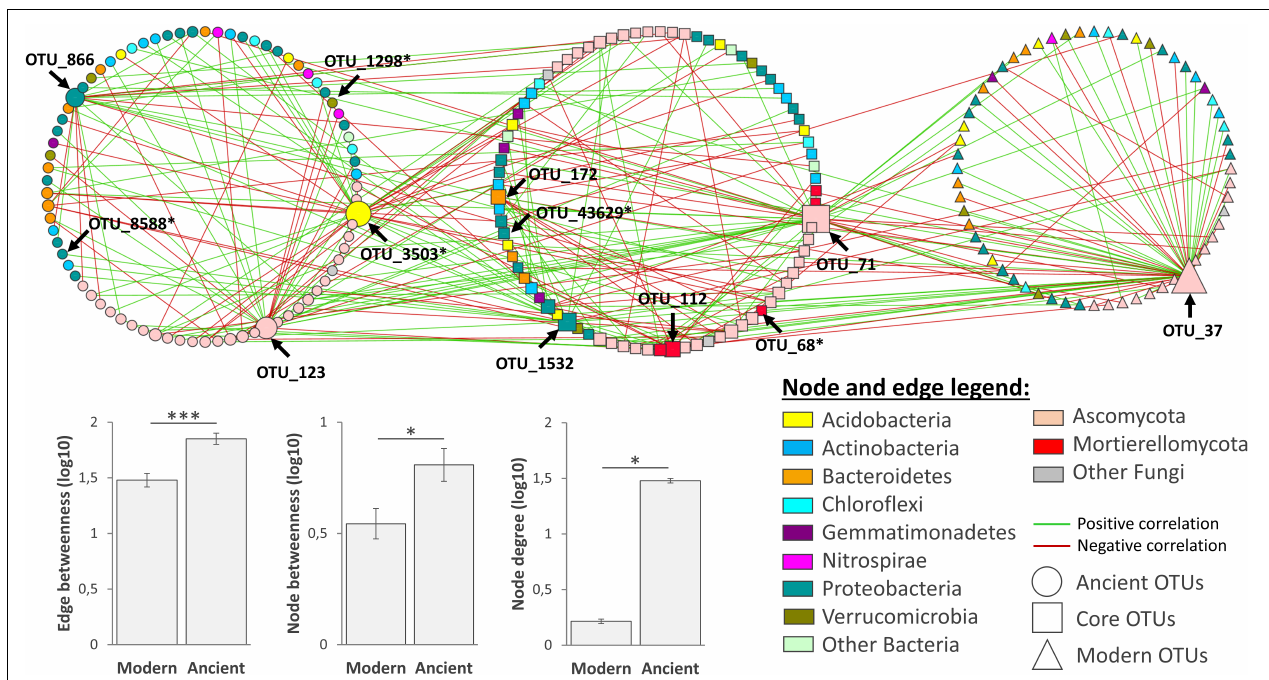
FIGURE 5 | Combined network analysis of rhizosphere microbiota associated to the modern ( N = 26) and ancient ( N = 24) wheat varieties. The modern and ancient networks were constructed using dominant OTUs based on partial correlations obtained with Poisson Log Normal models combining the bacterial and fungal datasets together ( ∼ 1 + block + offset). For visualization, both networks were merged into one and clustered in three to feature: (i) unique OTUs of the ancient network on the left, (ii) common OTUs in the middle, and (iii) modern OTUs on the right. OTUs of interest (keystone or discriminant OTUs from Supplementary Table 5 ) are indicated with an arrow. Bar charts represent average network complexity indices estimated from edges or nodes (Kruskal–Wallis test, * p < 0.05; *** p <